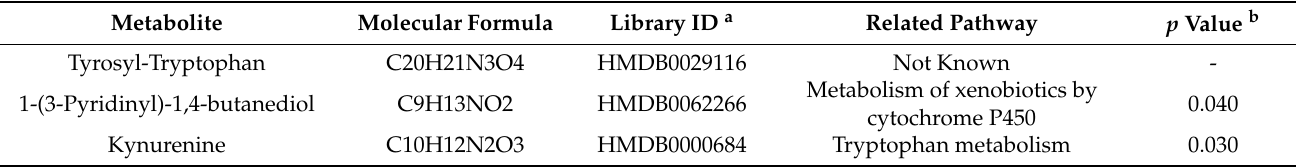
Table 4. The metabolic pathways for identified urinary metabolic biomarkers.